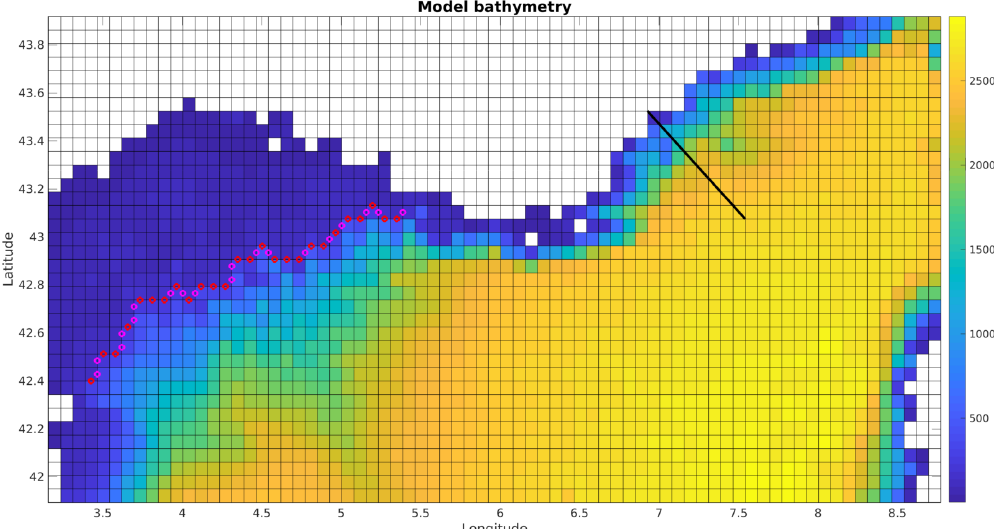
Figure 2. Zoom of the MED model grid, with the positions for computing the Northern Current metric (black line) and the cross-shelf transport metric (magenta and red